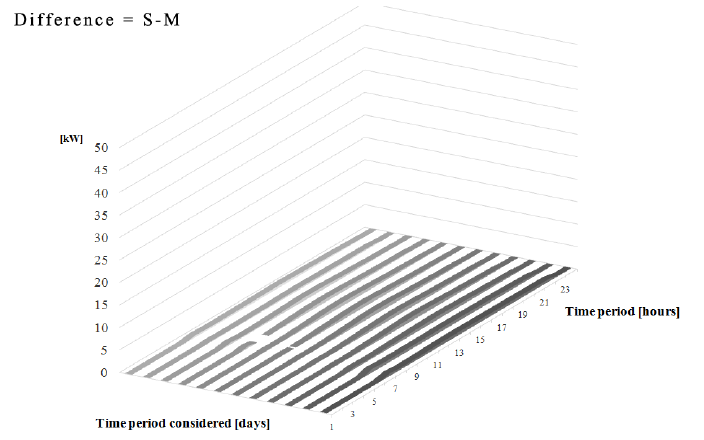
Figure 1. Example of 3D comparative plots.